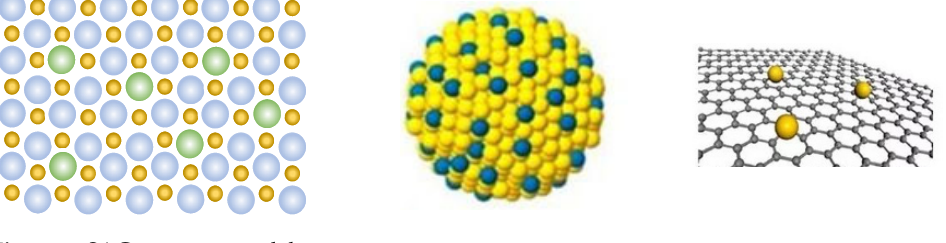
Figure 1. SAC structure